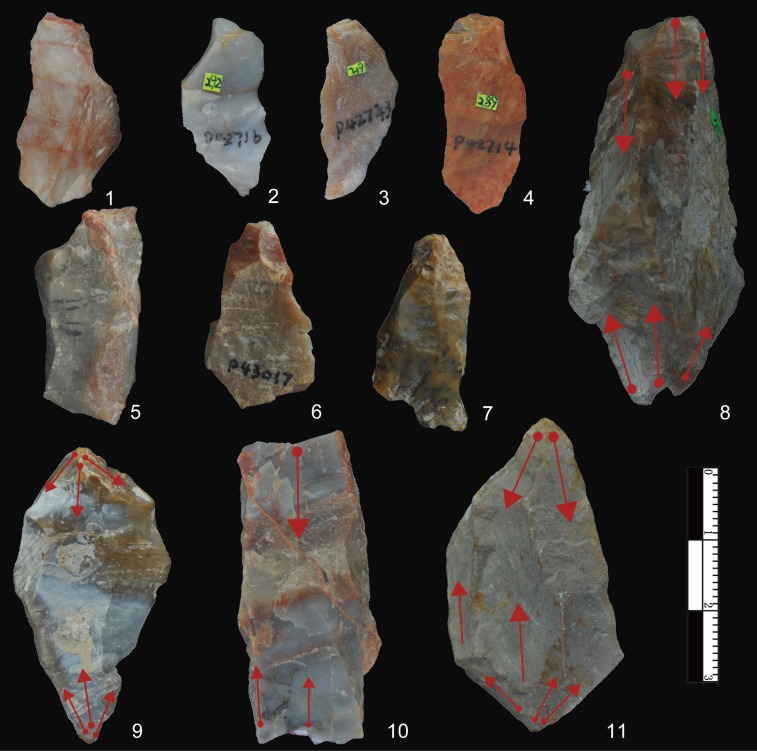
Bipolar products from DGT.No. 1–7 are splinters from bipolar percussion; No. 8–11 are bipolar cores which show percussion or battering scars on two edges (the arrows indicate the opposed flaking scars).